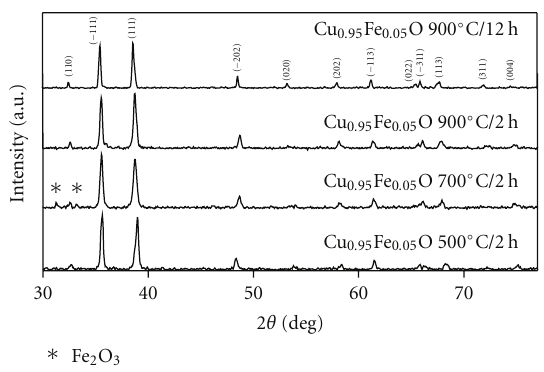
Figure 1: XRD patterns of 50-hour refluxed nanocrystalline Cu 0 . 95 Fe 0 . 05 O annealed at di ff erent temperatures.